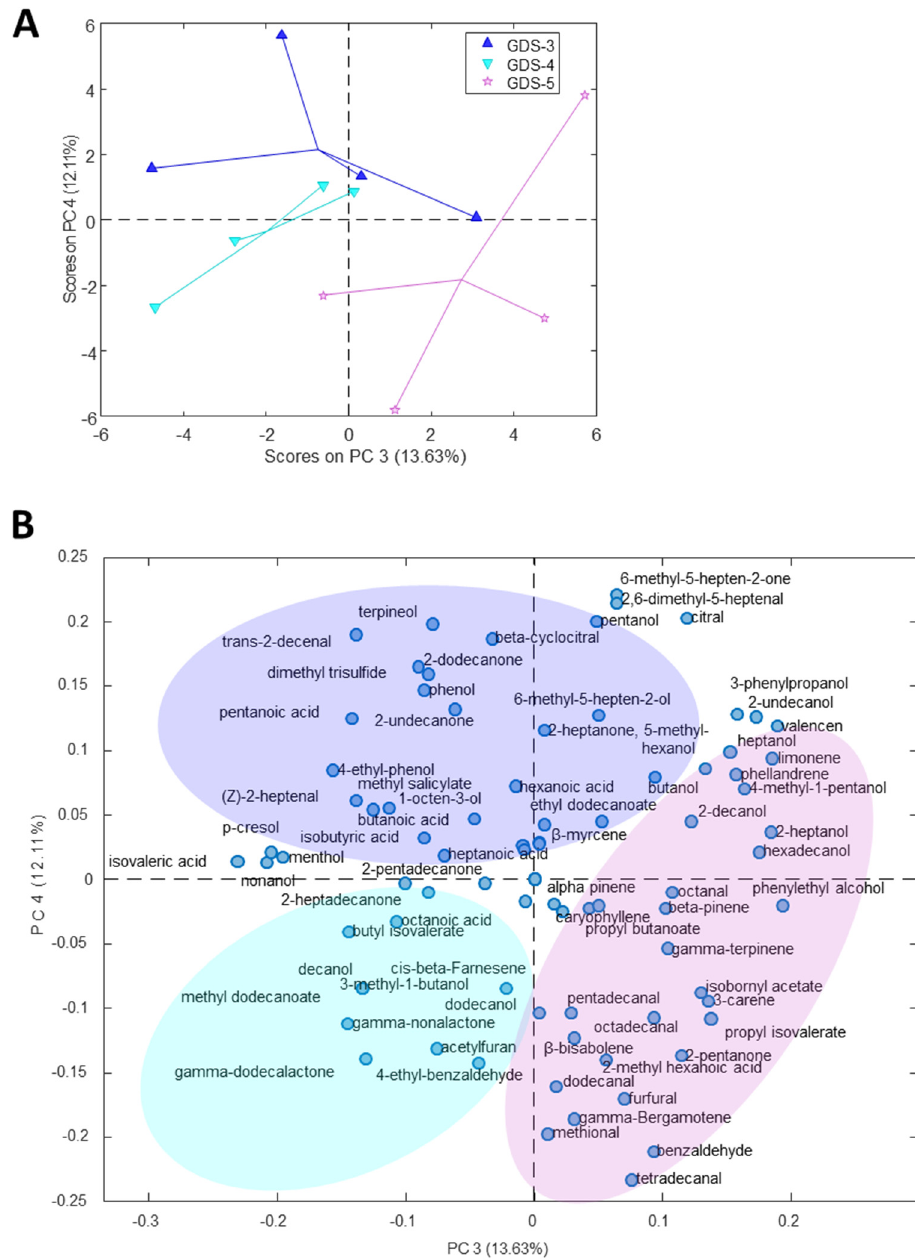
Figure 3. Principal component analysis (PCA) of the fecal volatile organic compounds (VOCs) in Alzheimer’s disease (AD). The ( A ) scores and ( B ) loadings plots of the PCA model developed with the fecal samples from the AD patients and the relative peak area of the total VOCs identified; (n = 12, AD patients; 4 per stage).